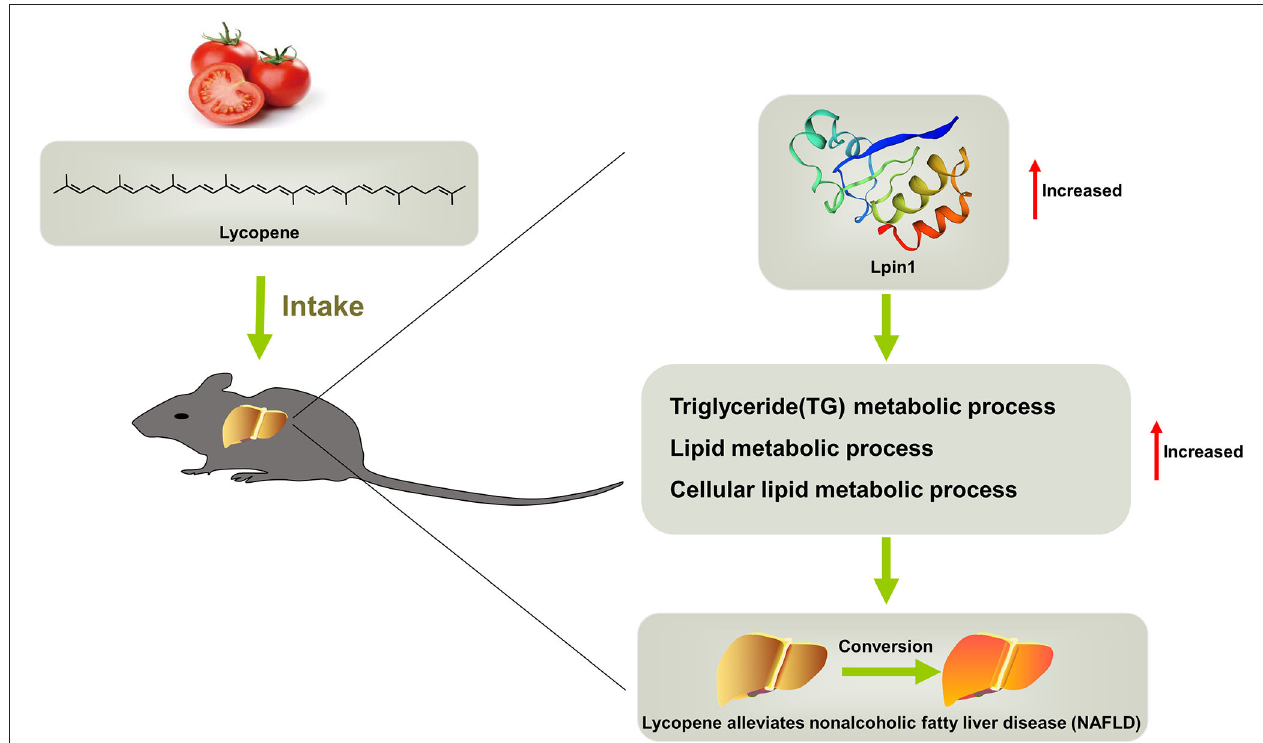
FIGURE 7 | Schematic representation of the mechanisms that mediate lycopene-provided protection against NAFLD.